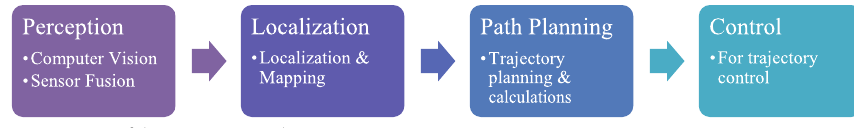
Fig. 3 Stages of the autonomous driving system